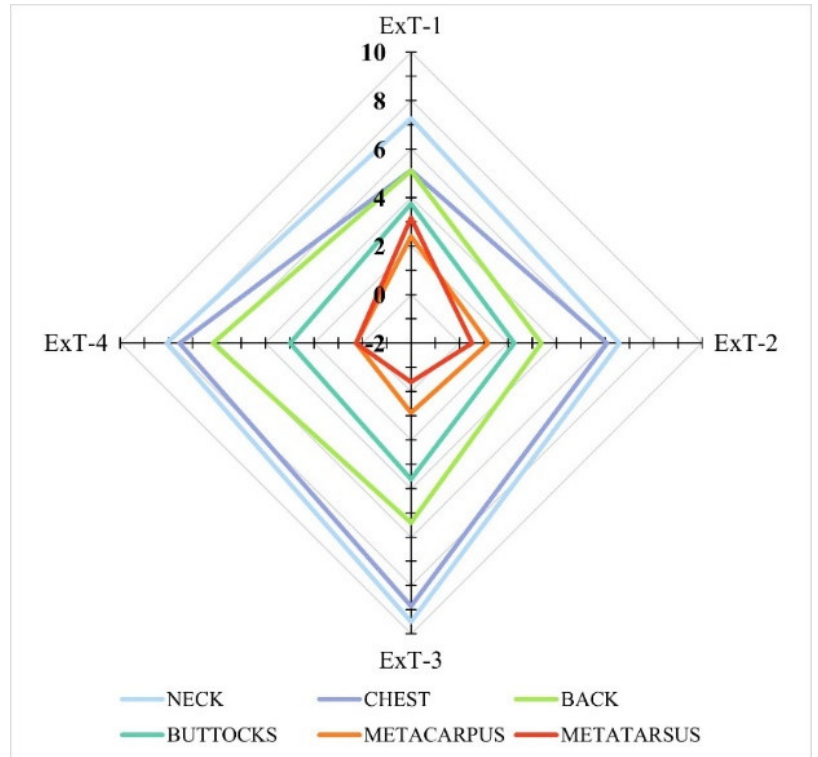
Figure 3. Graphical presentation of heating (temperature differences of body surface regions before and after exercise; scaling: absolute temperatures (°C)). ExT-1 to ExT-4 — exercise tests 1 to 4.